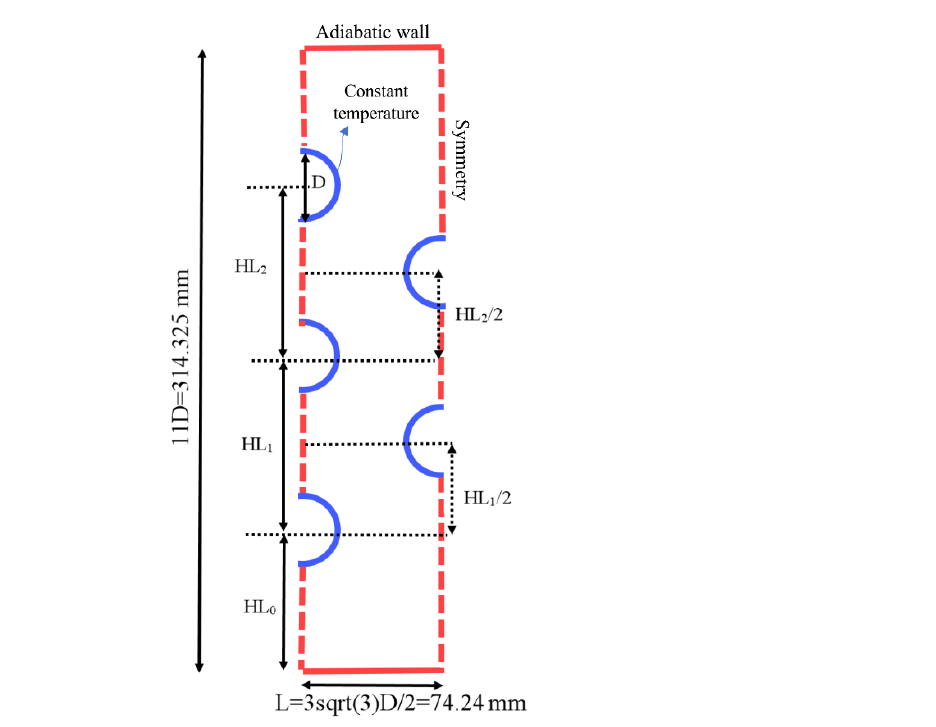
Figure 1. The schematic of the proposed heat exchanger in this study. Table 1. Thermo-physical properties of RT35 [33].